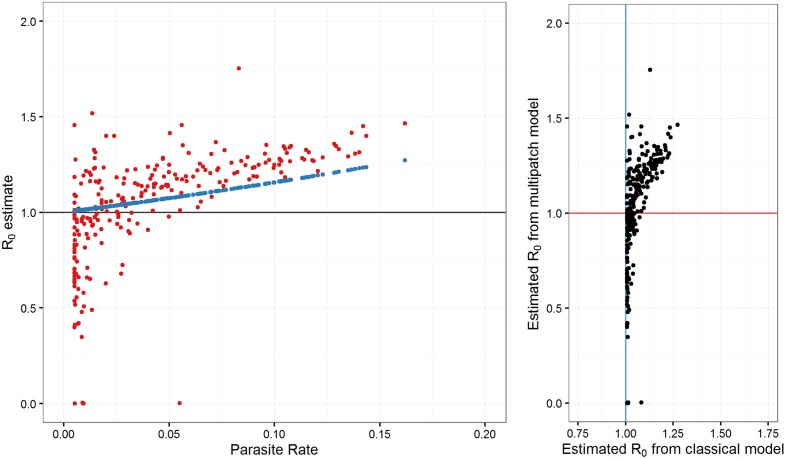
R0 estimates using steady state analyses of multipatch model with mobility and classical model without mobility for all patches with nonzero PR.Left panel: R0 estimates using both models compared with observed PR in each patch. Right panel: Relationship between R0 estimates from both models.